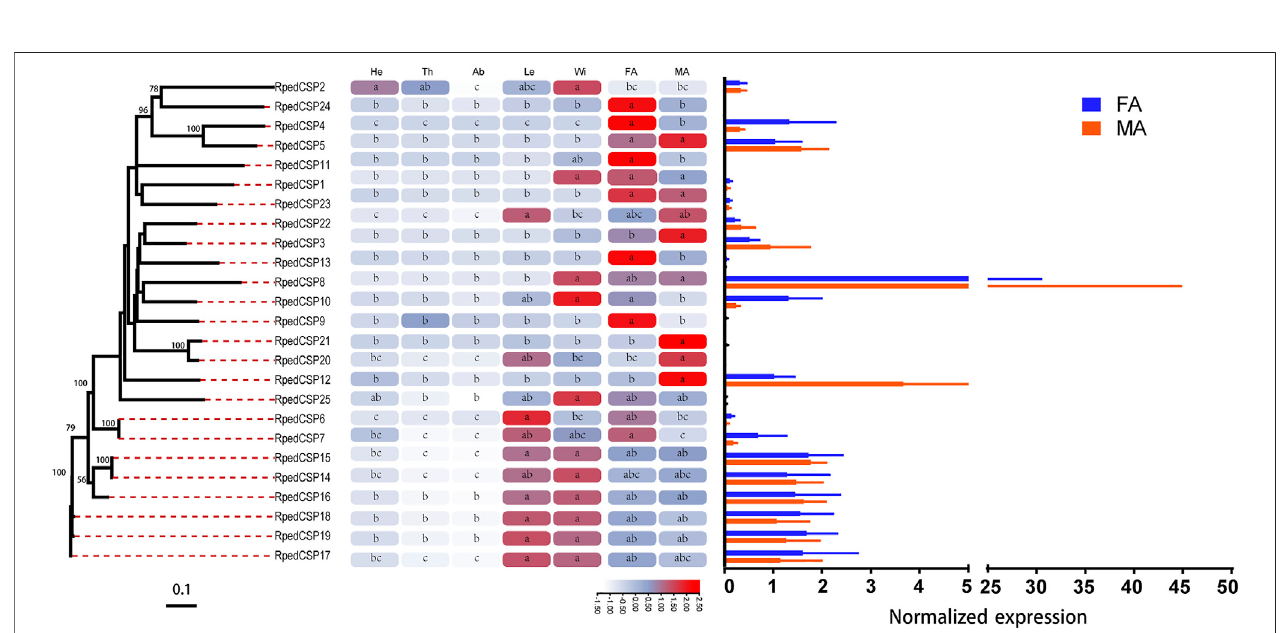
FIGURE 7 | Tissue expression pro fi les of R. pedestris CSPs by qRT-PCR. The relative expression level is presented as mean ± SE ( n = 3). The heatmap use Log2 and row scale based the relative expression level data. Different capital letters mean a signi fi cant difference between tissues ( p < 0.05, ANOVA, LSD). He, heads; Th, thoraxes; Ab, abdomens; Le, legs; Wi, wings; FA, female antennae; MA, male antennae.